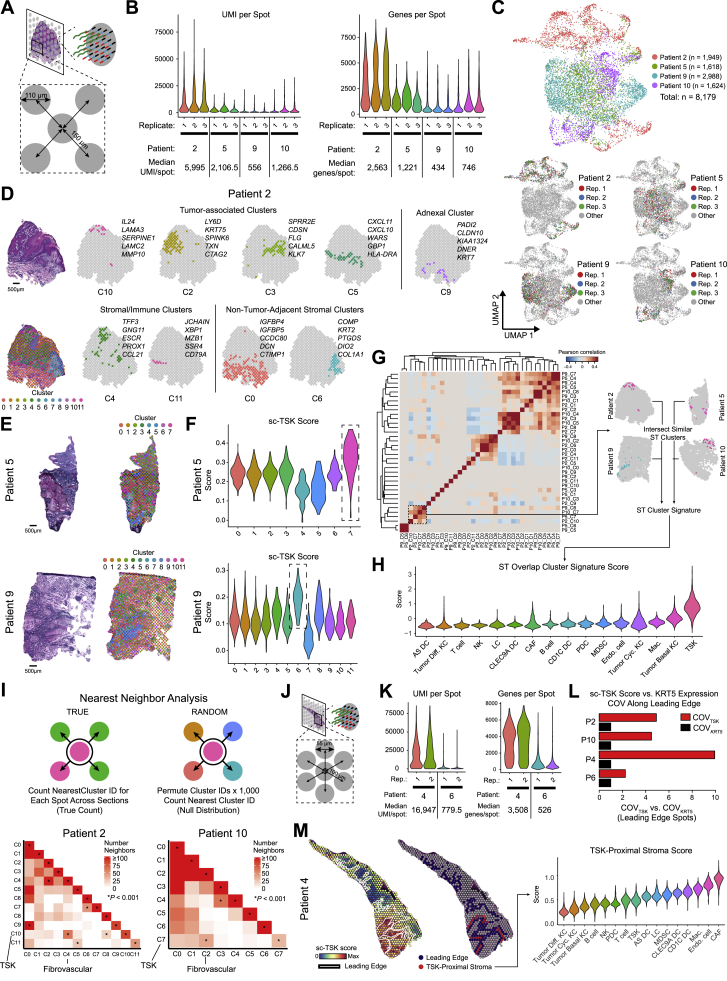
Spatial Transcriptomics Identifies TSK Localization and Patterns of Cluster Adjacency, Related to Figure 3(A) Spatial transcriptomics (ST) spot size and resolution. (B) Violin plots of UMI counts per spot and genes per spot across tissue section replicates. (C) UMAP of all transcriptome spots labeled by patient (top) and replicate (bottom). (D) Tumor-associated spot clusters (clusters encompassing annotated tumor regions in sections), stromal or immune-associated, and non-tumor-adjacent stromal and adnexal spot clusters projected individually with labeled top differentially expressed genes. (E) Hematoxylin and eosin (H&E) staining of sections from Patients 5 and 9 with unbiased clustering of spots based on global gene expression within individual spots. Scale bar = 500 μm (F) Violin plots of TSK scores of individual spots derived from scRNA-seq data (sc-TSK score) for each cluster. Dotted boxes outline clusters with highest average sc-TSK score. (G) and (H) Overlap correlation matrix of genes differentially expressed in ST clusters across all patients (G). Highlighted similar spatial clusters were used to generate ST Cluster Signature (n = 6 genes), and violin plots of ST Cluster Signature score by cell types in scRNA-seq data (H). (I) Top, schematic of nearest neighbor analysis for spots. Bottom, heatmaps showing number of nearest neighbor identities for each cluster. ∗indicates p < 0.001 by permutation test. (J) Visium platform ST spot size and resolution. (K) Violin plots of UMI counts per spot and genes per spot across tissue section replicates from Visium. (L) Coefficient of variation of sc-TSK score (COVTSK) normalized to COV of KRT5 expression (COVKRT5) across leading edge spots in patient ST data. (M) Left, spatial feature plot of sc-TSK score. Middle, spots annotated by leading edge (navy) and TSK-proximal stroma (red). Differential expression was performed with TSK-proximal stroma spots versus all other spots in tissue. Right, Violin plots of TSK-proximal stroma scores (n = 209 genes, Wilcoxon rank-sum test, adjusted p value < 0.05) by cell types in scRNA-seq data (STAR Methods).